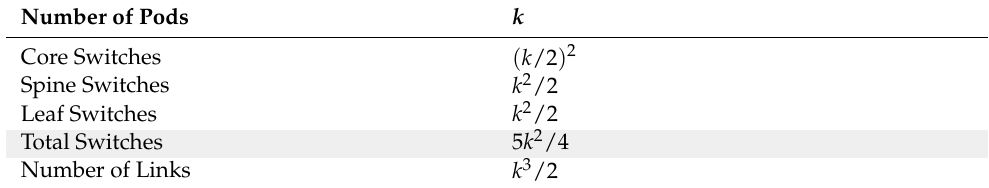
Table 1. Fat-Tree topology summary